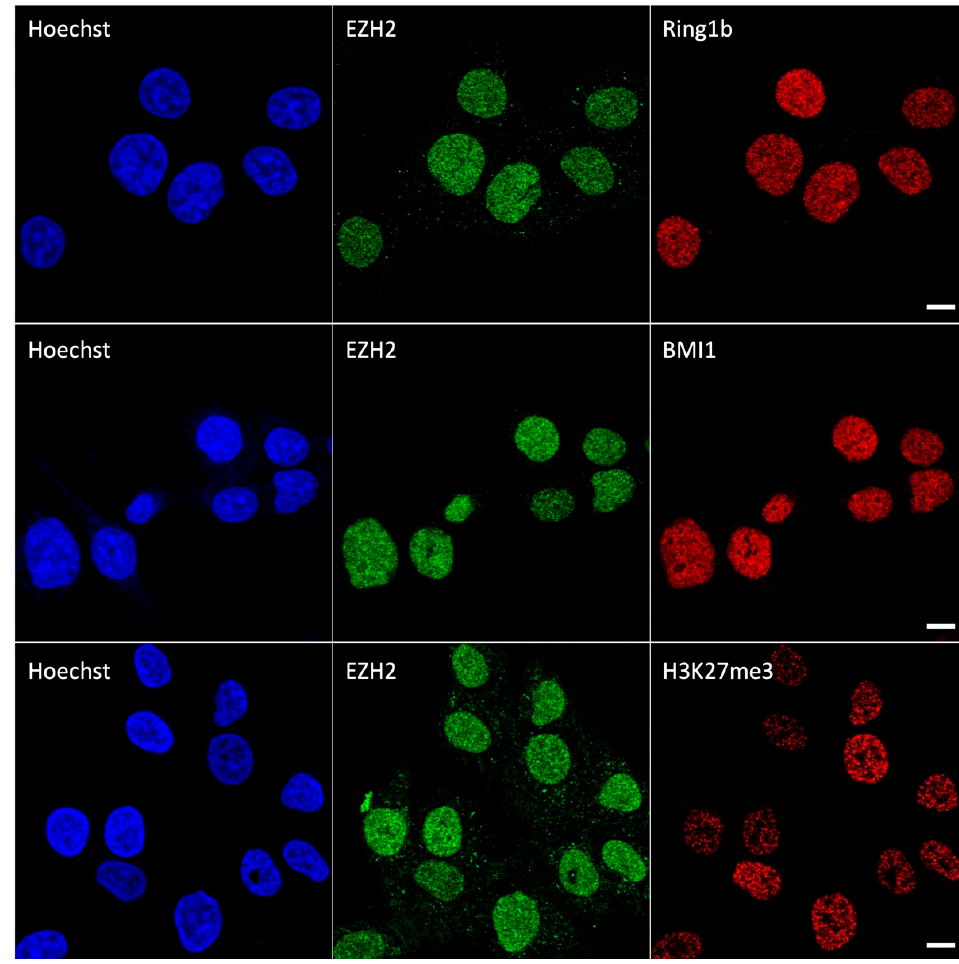
Figure 1. Confocal images of HCC827 nuclei immunolabeled by EZH2/RING1b ( upper row ), EZH2/BMI1 ( central row ), and EZH2/H3K27me3 ( lower row ). Scale bar: 10 µm.